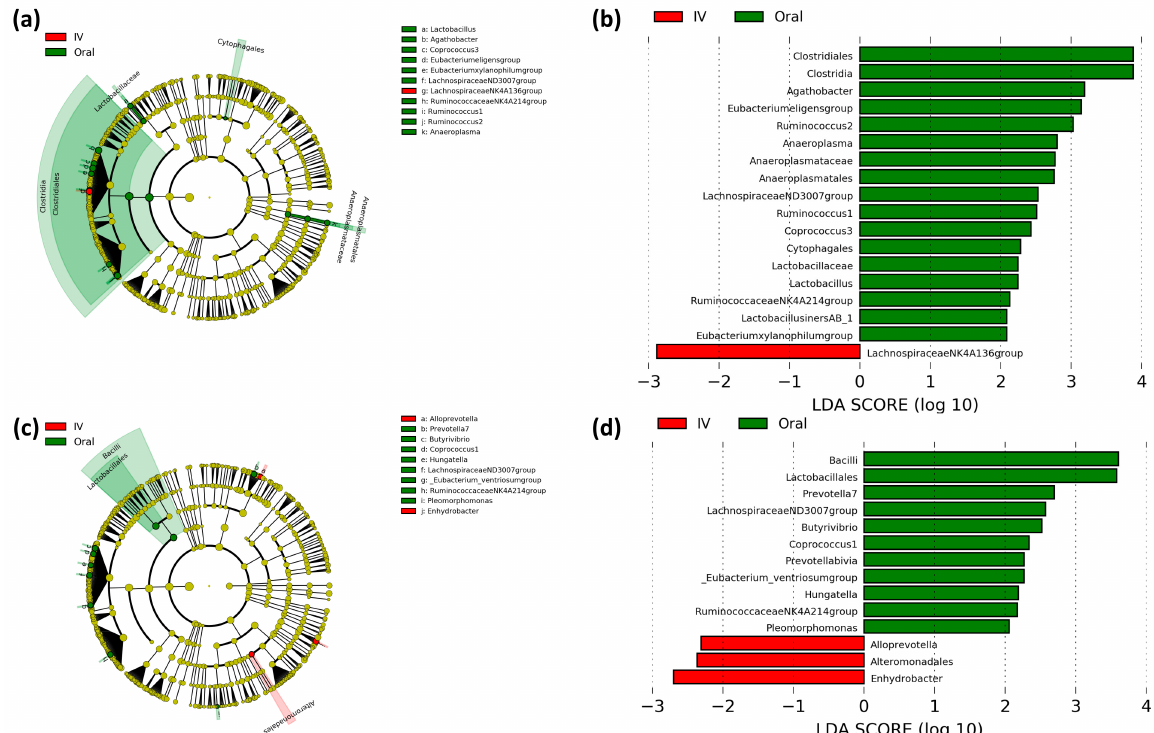
Figure 3. Linear discriminant analysis (LDA) effect size (LEfSe) comparing iron therapy on bacterial taxa in the on- and off-tumor microbiota. LEfSe cladogram and histogram of LDA scores for differentially abundant bacterial taxa between oral and intravenous (IV) iron-treated patients in off-tumor ( a , b ) and on-tumor ( c , d ) microbiota. Differentially abundant taxa from phylum to genus taxonomic levels were included. Taxa and nodes highlighted in green were more abundant in oral and red in IV iron-treated patients. Taxa with an LDA > 2 with a p -value ≤ 0.05 were considered statistically